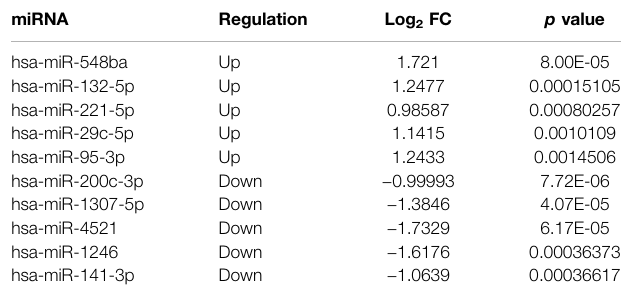
TABLE 2 | Top 10 differentially expressed circRNAs in decidua of URSA patients. circRNA